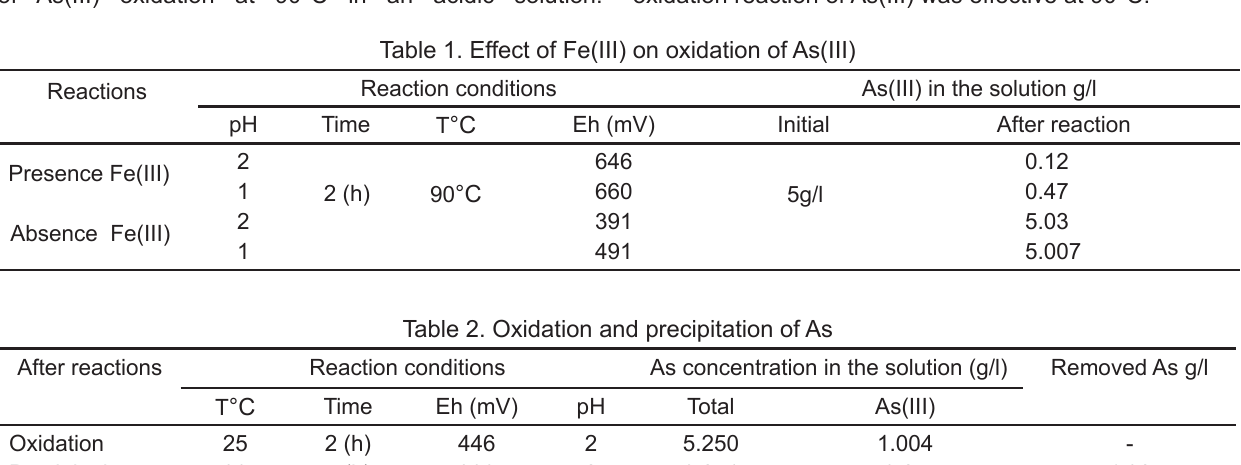
After reactions